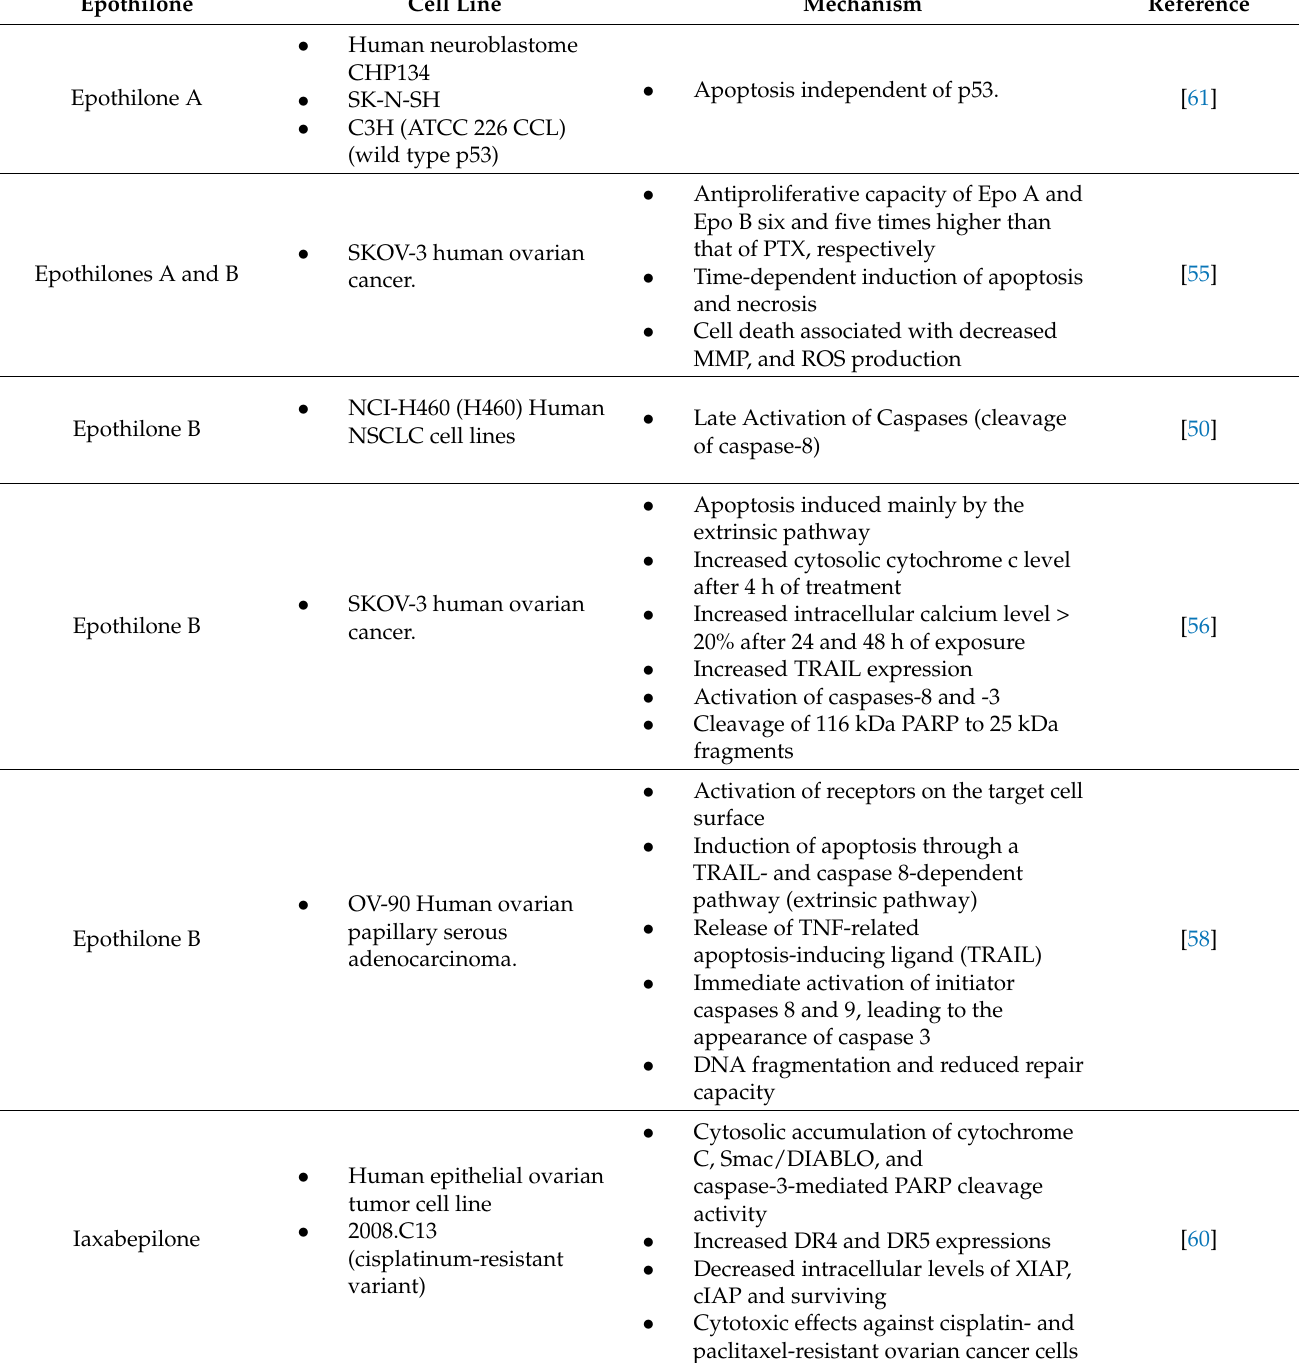
tumor, ovarian cancer, and central nervous system and many other tumors [67]. Table 2. Mechanism of action associated with apoptosis induced by different